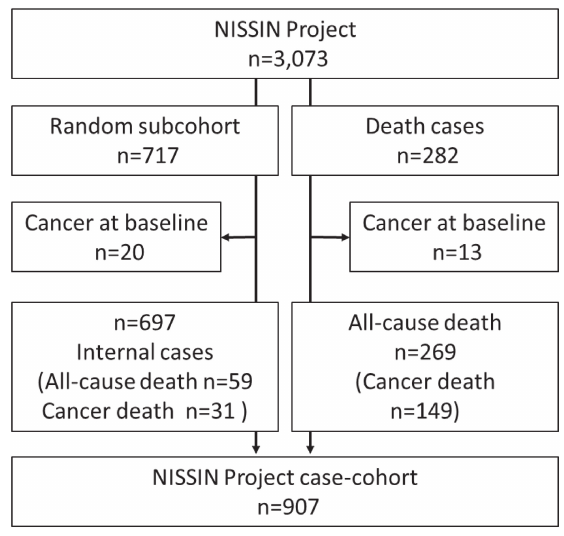
Figure 1. Study population